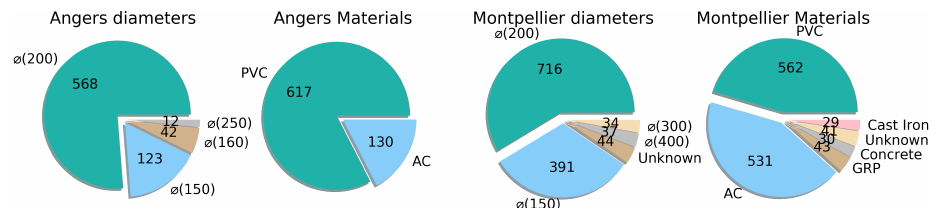
Figure 4. Diameter and material distribution for the Montpellier and Angers subsets. Only classes with more than 10 elements are represented